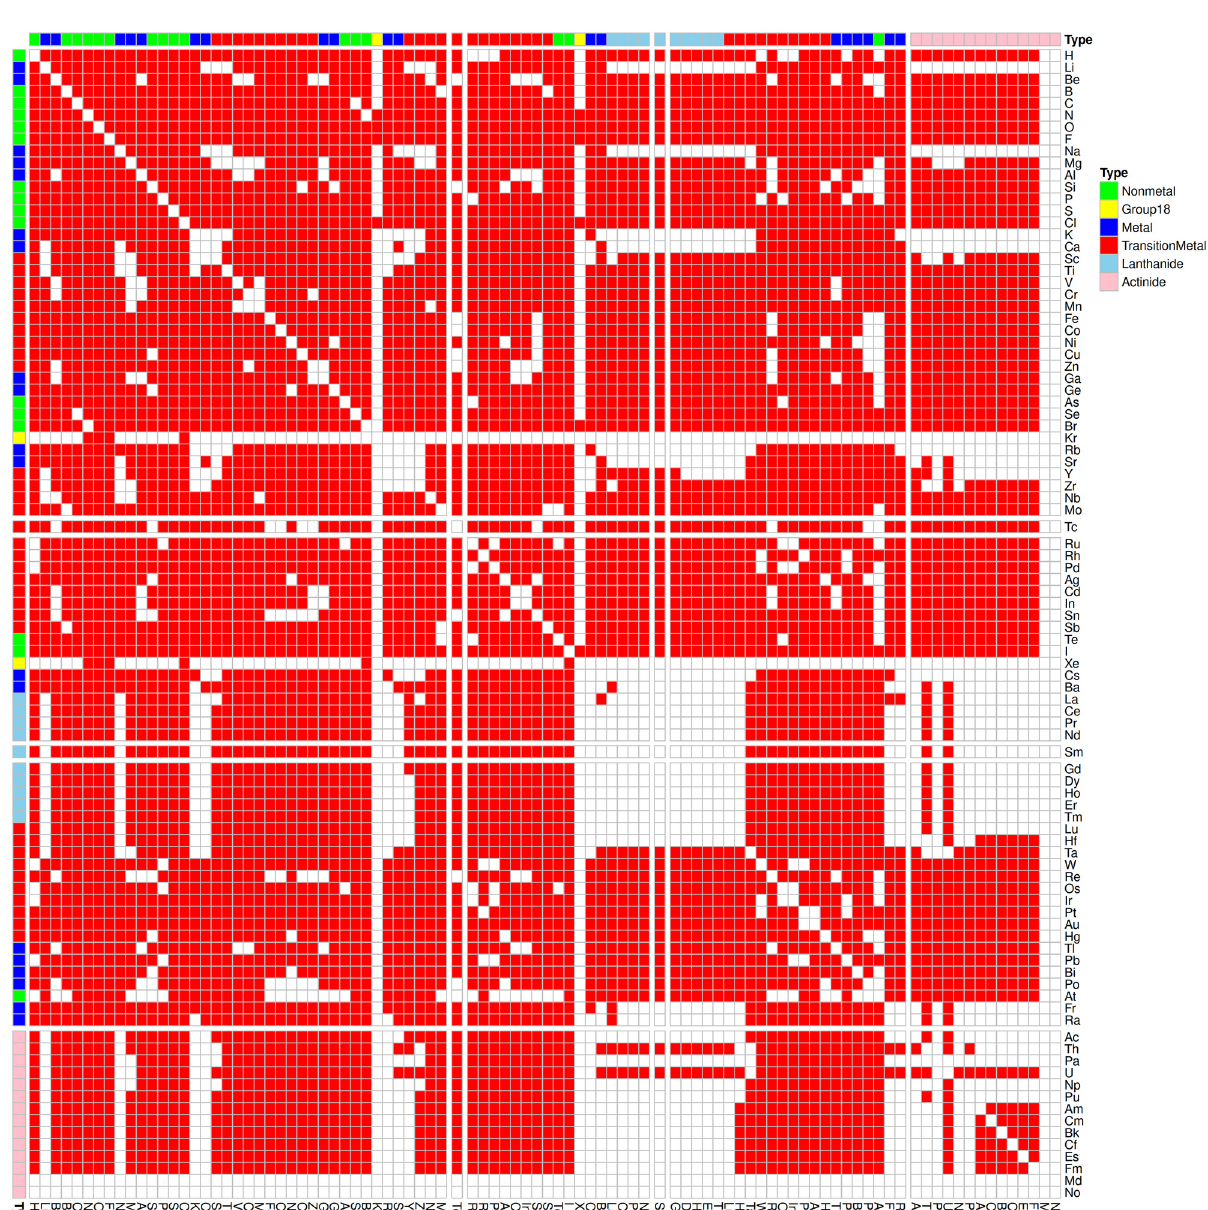
Figure 11: Chemical meaning analysis of PR under the scale of χ p